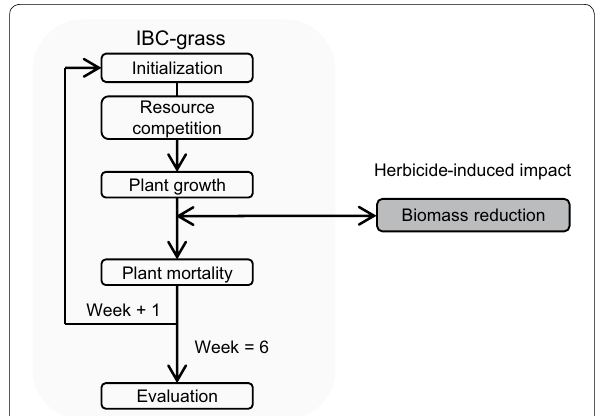
Fig. 1 Flowchart of the processes in the current version of IBC-grass. Several processes such as seed production, seed dispersal and biotic disturbances such as grazing are omitted in this version due to the short time scale of the experiments